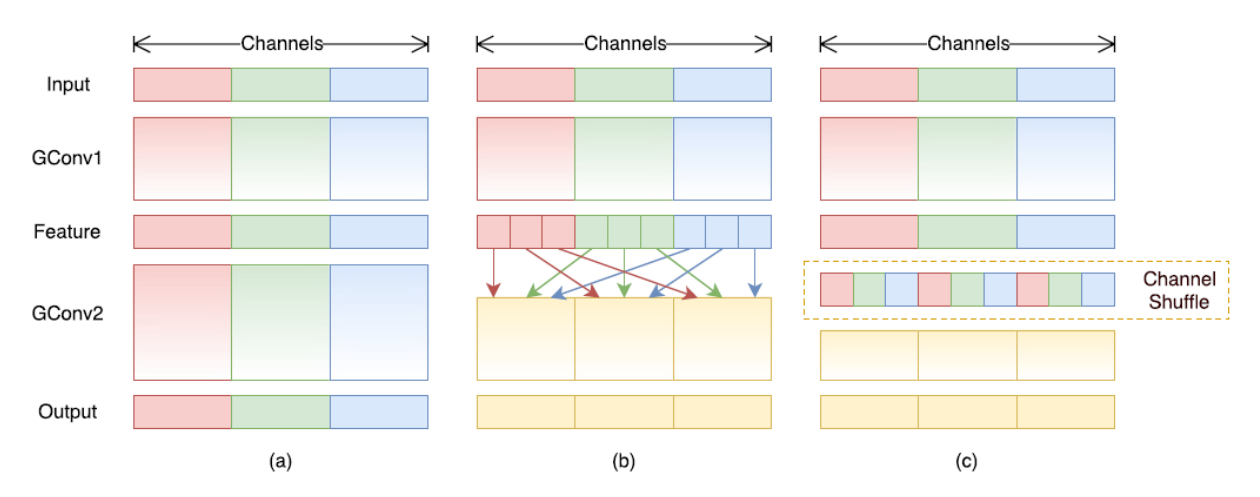
Figure 1. Channel shuffle [27].